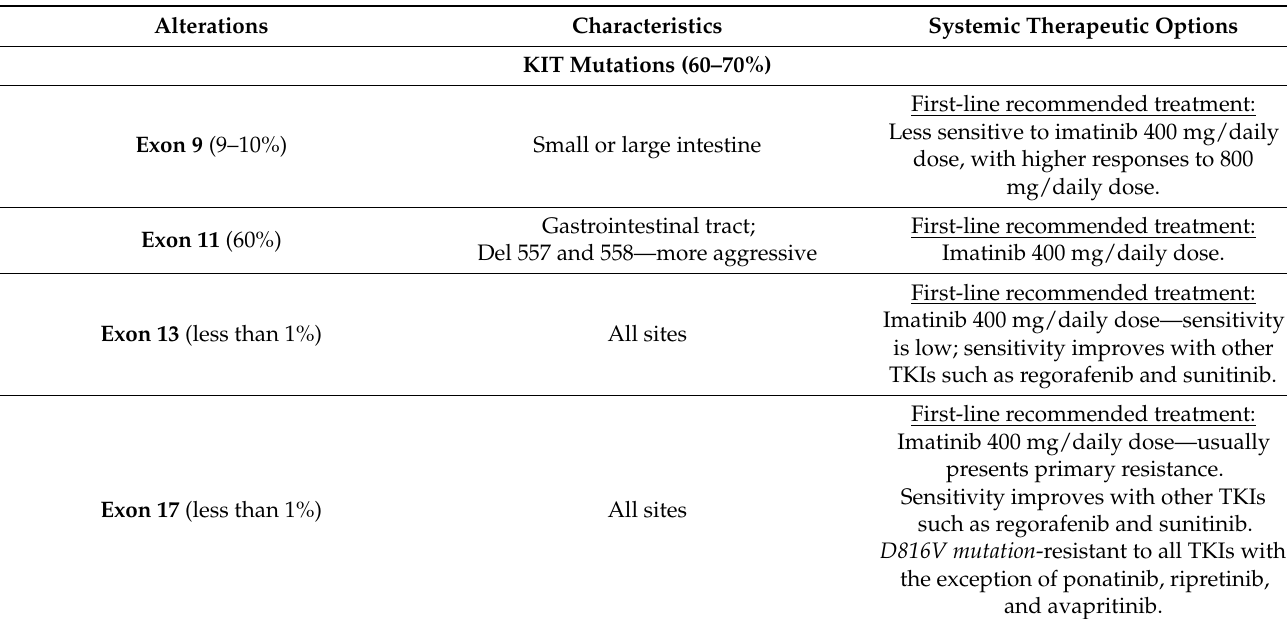
Table 2. GIST molecular subtypes and